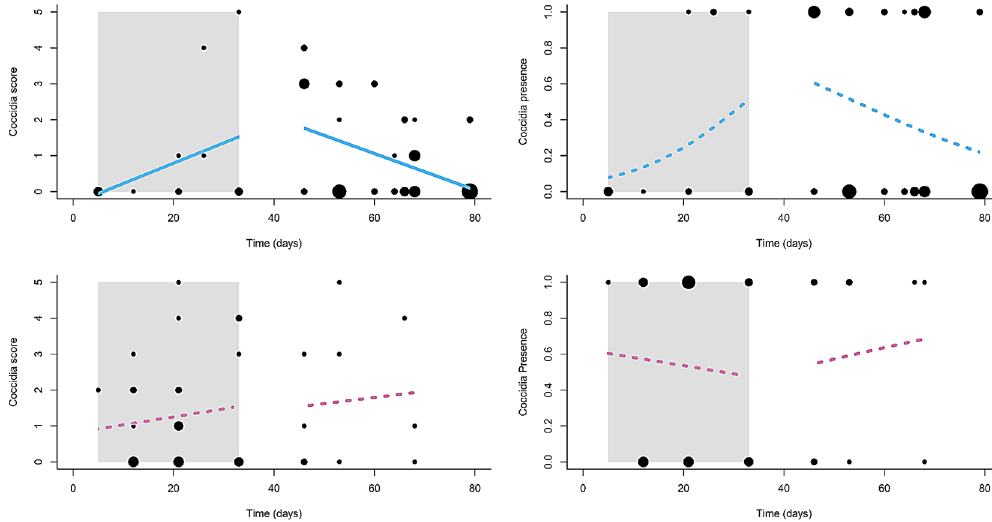
Figure 1. Scatterplots showing temporal variation in coccidiosis in males (blue lines) and females (pink lines) from our rural study site on the different feeder treatments (clean vs. dirty): ( a ) coccidia severity (shown as integer scores from 0 to 5), and ( b ) coccidia presence. Dirty-treatment data are shown against a gray background, whereas clean-treatment data are shown against the white background. Point size is proportional to the number of overlapping observations. Solid lines denote slopes that were statistically significant different from zero, whereas dashed lines signify slopes that did not differ from zero. The figure was drawn using R software 33 .